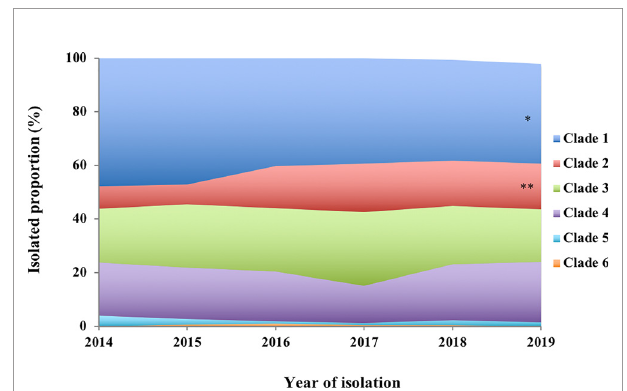
FIGURE 1 | Annual proportion of PspA clades 1 – 6 among the S. pneumoniae strains isolated from invasive pneumococcal diseases in 2014 − 2019. Mantel – Haenszel test of trends corrected using Bonferroni ’ s method to perform an analysis of the trends for the proportions of each clade from 2014 to 2019. * p < 0.05, ** p <